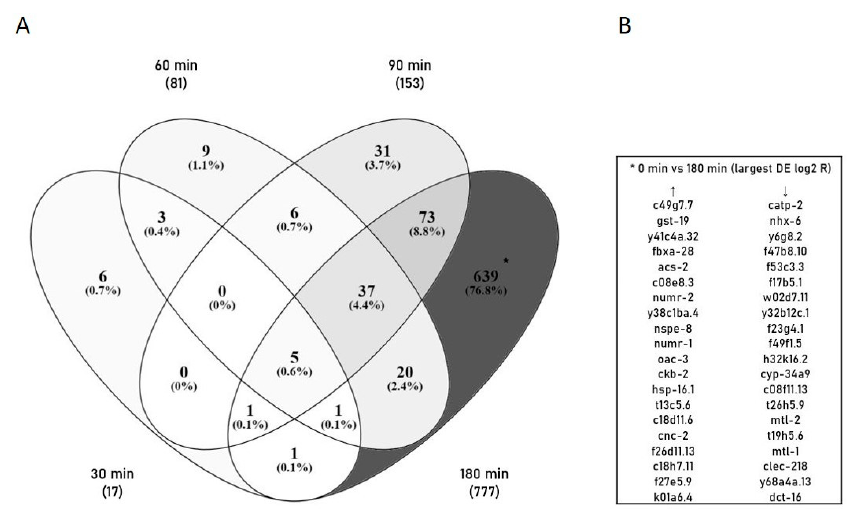
Figure 3. ( A ) Overview of time-specific DEGs at 30 min, 60 min, 90 min and 180 min 100 mM MnCl 2 exposed C. elegans compared to non-exposed controls. Venn diagram identified increase in total number of DEGs with increasing exposure times (30 min vs. 0 min: 17, 60 min vs. 0 min: 81, 90 min vs. 0 min: 153, and 180 min vs. 0 min: 777). ( B ) Additionally, most intense DEGs only present at 180 min vs. 0 min are listed. DEGs were illustrated using Venny [25].